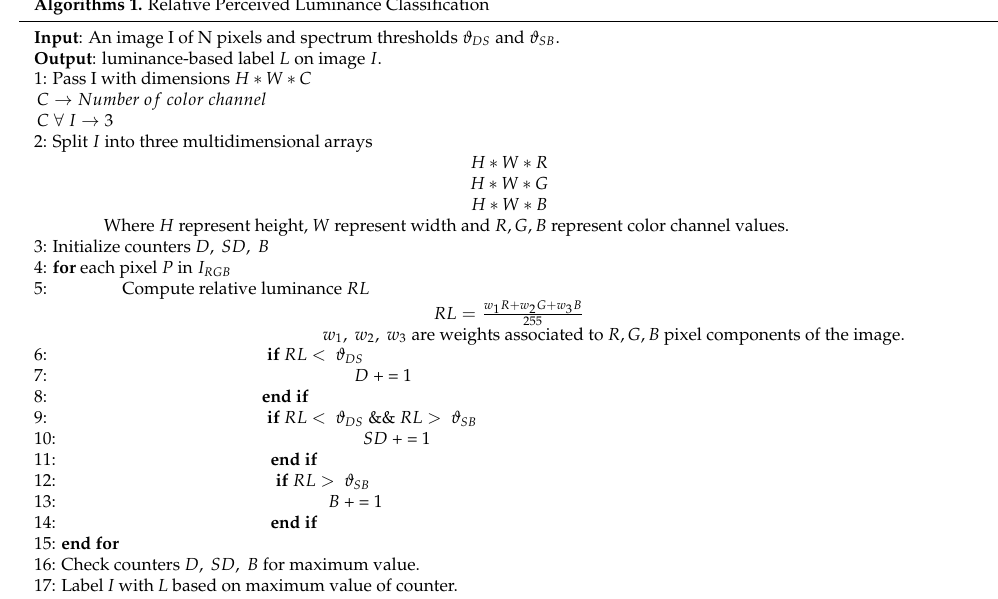
Proposed Algorithm 1: Relative Perceived Luminance Classification Algorithms 1. Relative Perceived Luminance